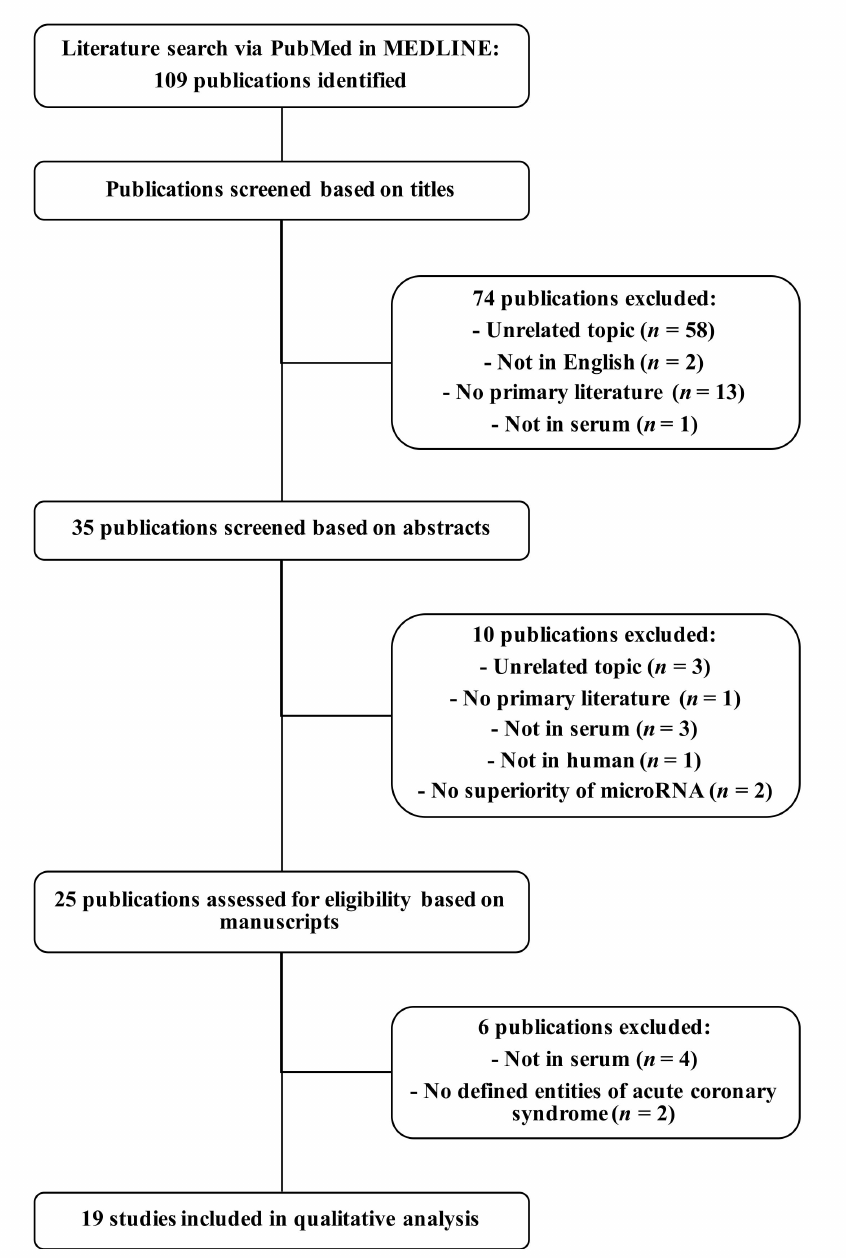
Figure 1. Workflow of the literature review about potential diagnostic serum microRNAs for my- ocardial infarction. The literature search was conducted via PubMed in the MEDLINE database. From 109 publications, 19 articles were identified presenting potential diagnostic serum microRNAs for myocardial infarction in human. Abbreviation: n , number of